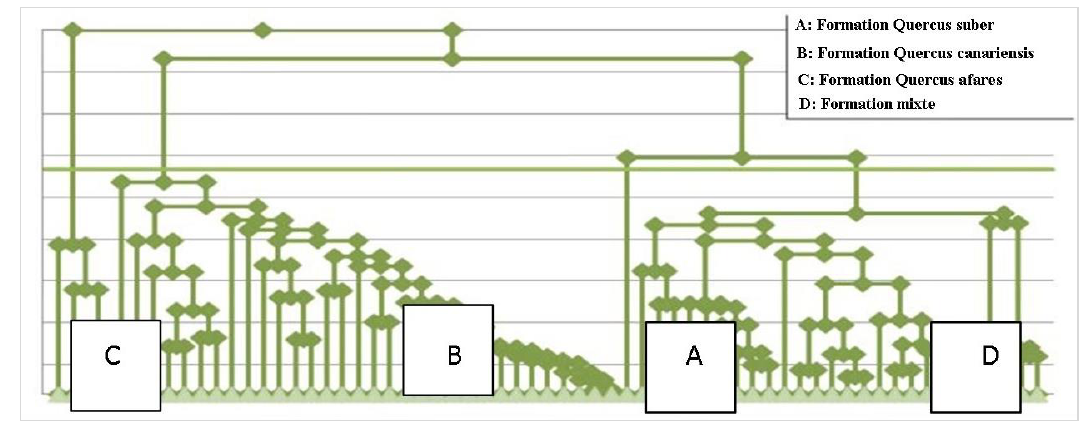
Fig. 5. Hierarchical classification of forest stands in Guerrouche forest